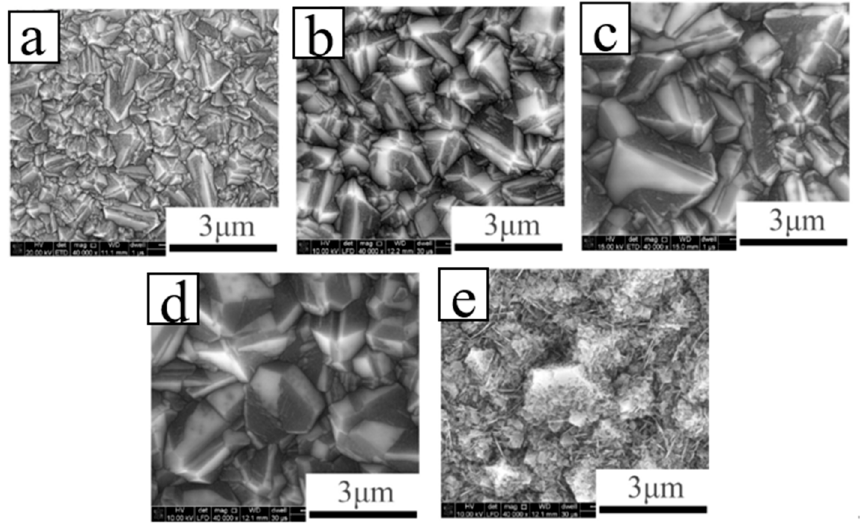
Figure 6. SEM images of BDD films grown with flow rate: ( a ) B 0 sccm, ( b ) B 0.5 sccm, ( c ) B 1 sccm, ( d ) B 2 sccm, ( e ) B 5 sccm [64]. ( d ) B 2 sccm, ( e ) B 5 sccm